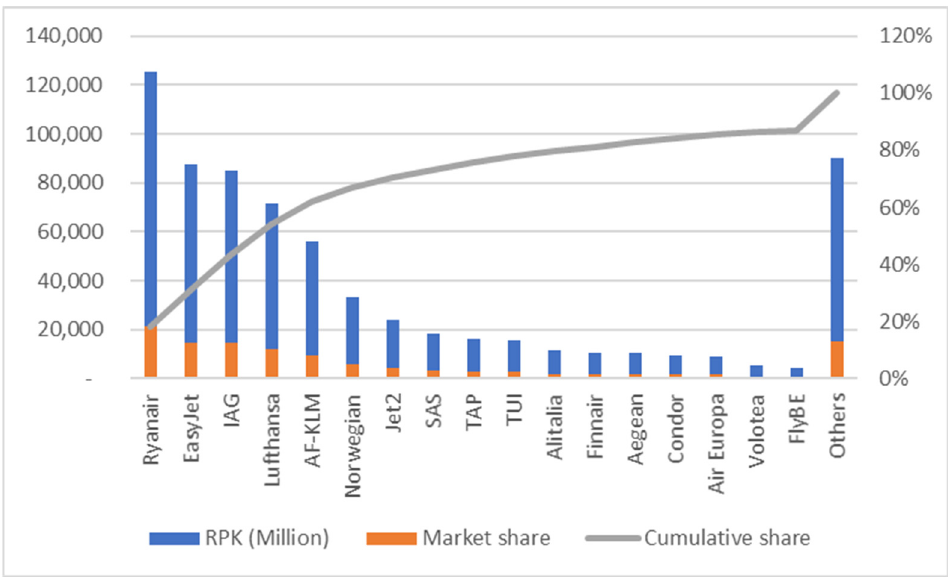
Figure 2. Western Europe’s largest airlines and airline groups by intra-Western Europe traffic volume (in millions RPK) in 2019. Authors’ own figure, based on Sabre Market Intelligence segment data.